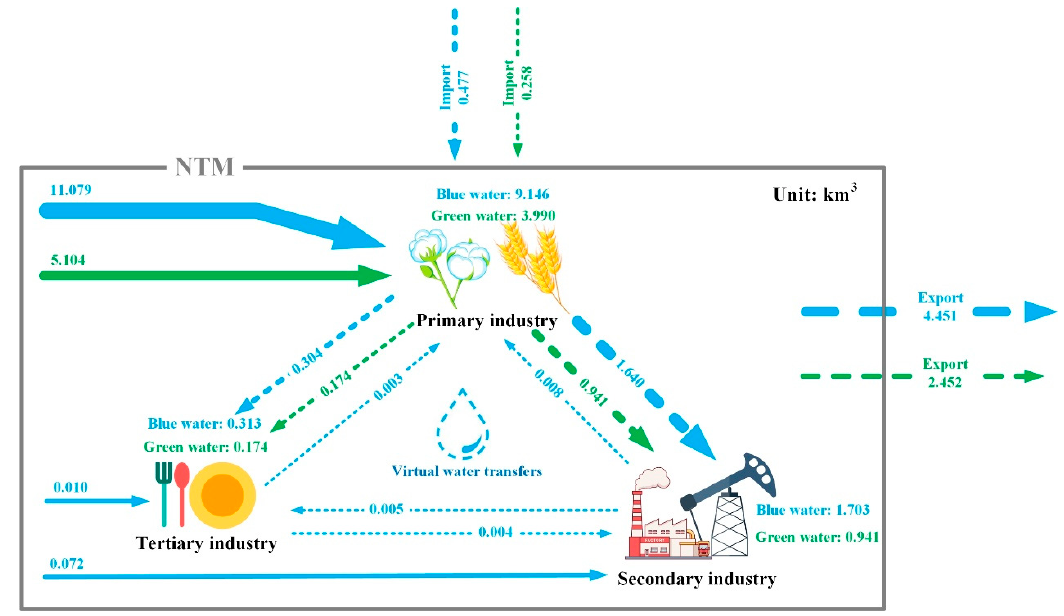
Figure 5. Virtual water inter-industry flow, import, and export in NTM.